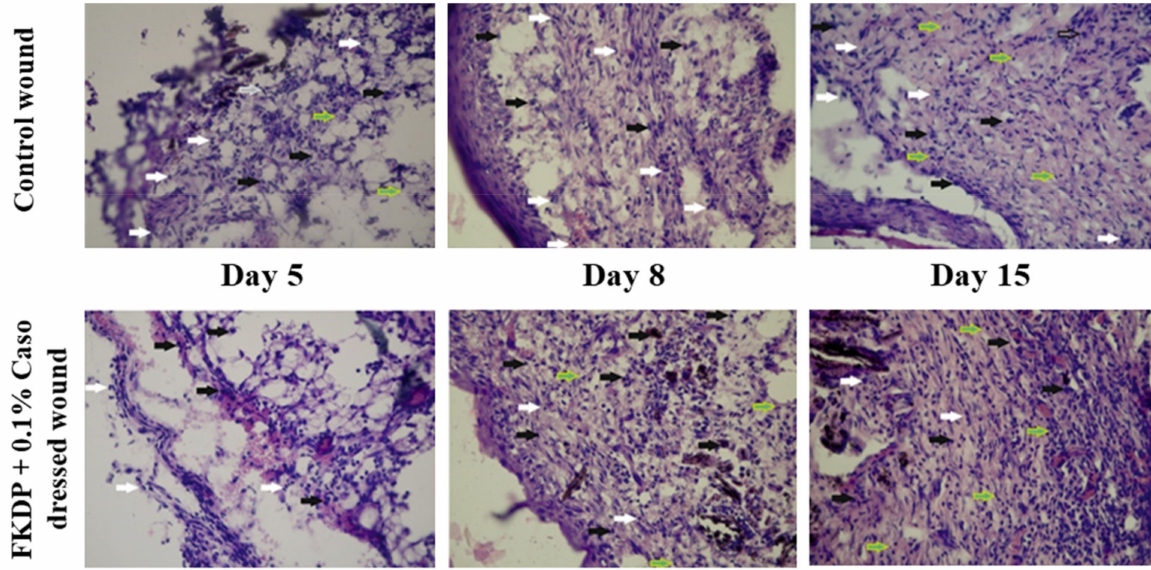
Figure 3. Microscopic view of the control and FKDP-0.1%casomorphin-treated wounds during the healing process. H&E. white arrow-neutrophils, black arrow-macrophages, green arrow-multinucleated giant cells, black and white arrow- lymphocytes; magnification 100 × (color online, black and white in